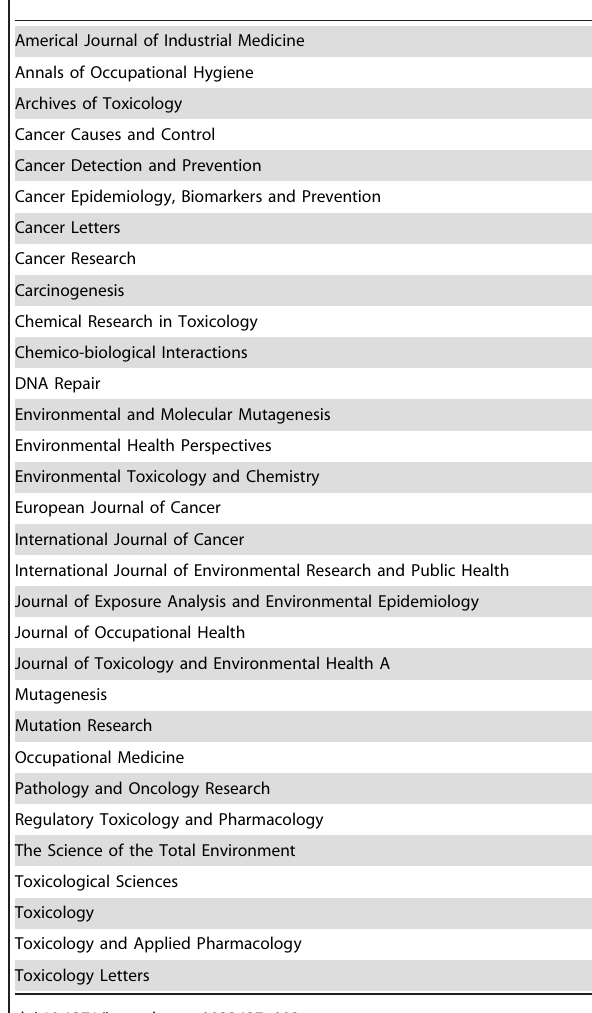
Table 3. Journals used for the user